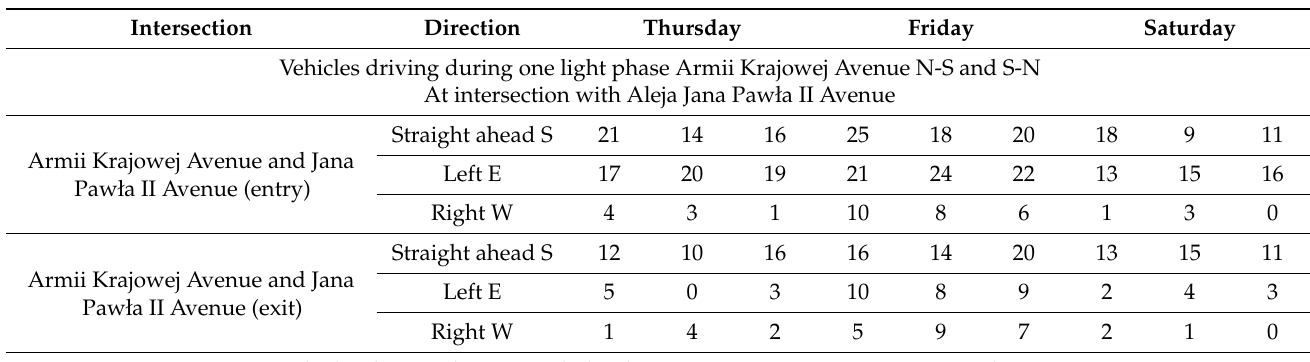
Table 2. Results of